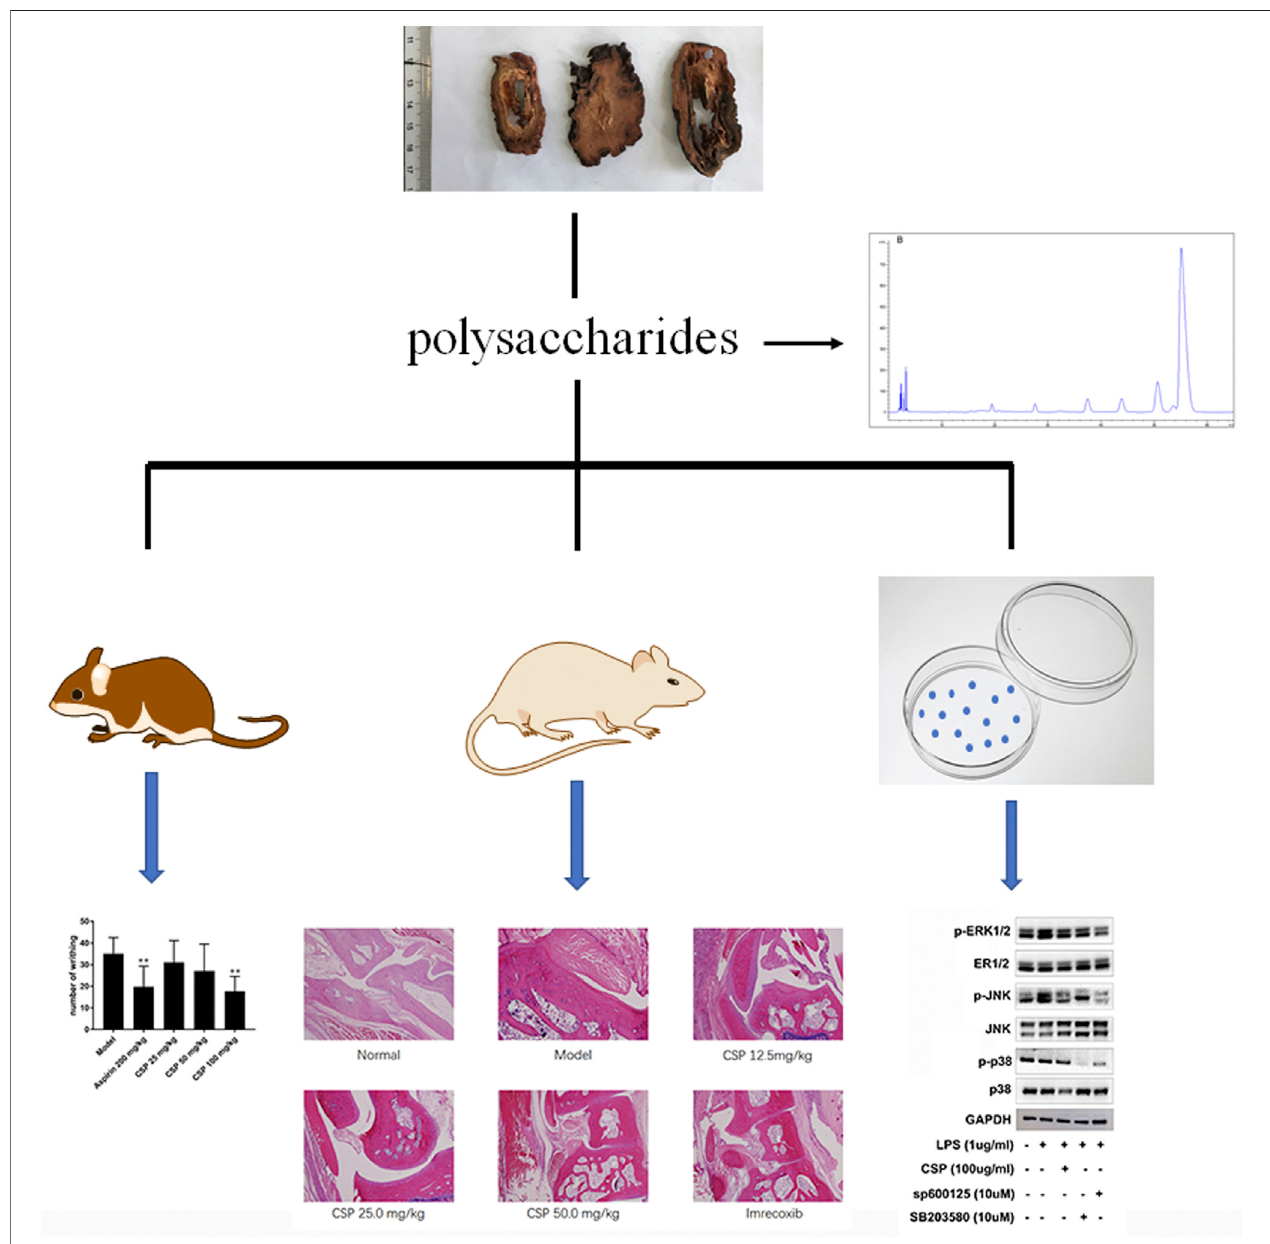
FIGURE 1 | Work fl ow of analgesic and anti-in fl ammatory activities of CSP.